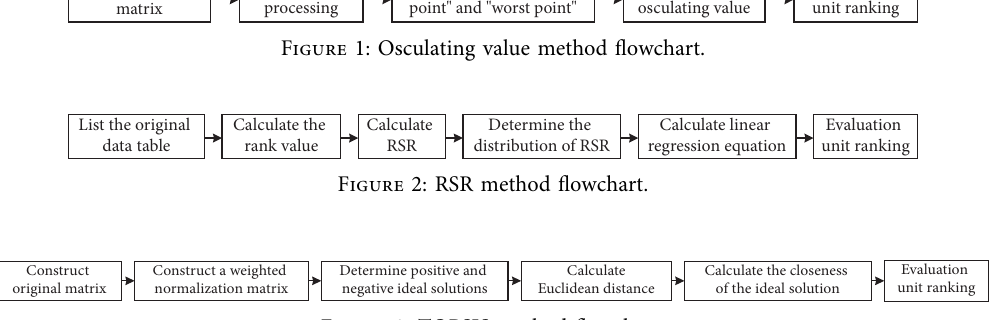
Figure 3: TOPSIS method flowchart.